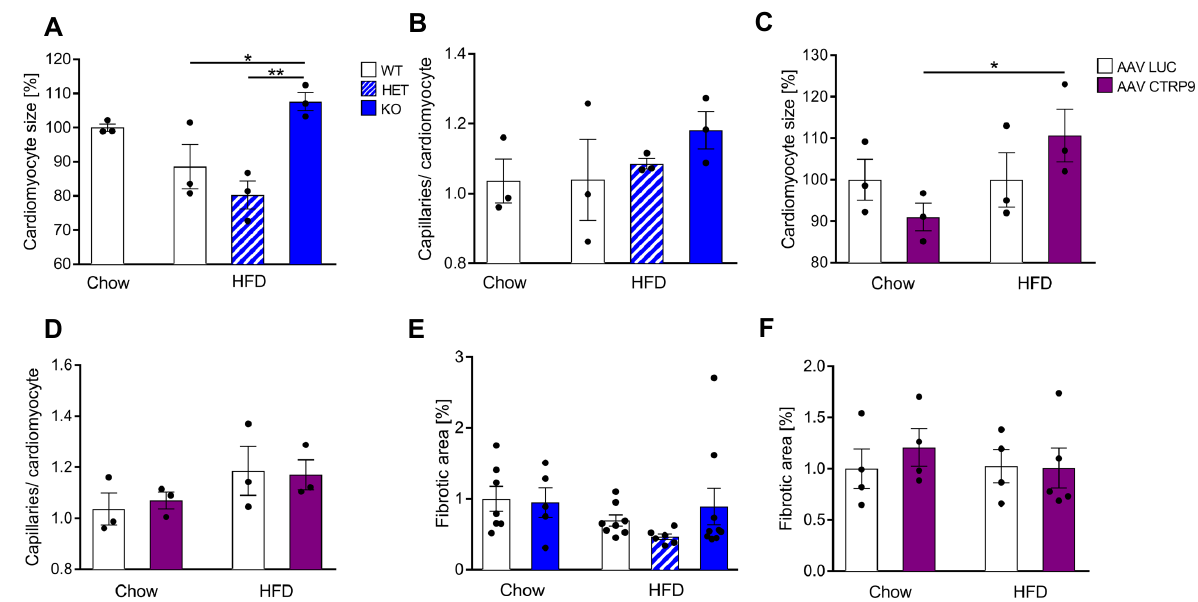
Figure 7. Histological analyses in mouse hearts with CTRP9 knock-out and overexpression. (A) Cardiomyocyte size measured as cross-sectional area and capillary density, measured as capillaries/ cardiomyocyte ratio (B) in the indicated mice. WT: wild-type mice; KO homozygous and HET heterozygous CTRP9 knock-out mice. HFD: high fat diet. (C) Cardiomyocyte size and capillary density (D) in the indicated mice treated either with AAV Luc (control) or AAV CTRP9 (leading to myocardial CTRP9 over- expression). (E-F) Quantification of cardiac fibrotic area in the indicated mice. Data are shown as mean ± standard error of the mean (SEM). *p<0.05, **p<0.01